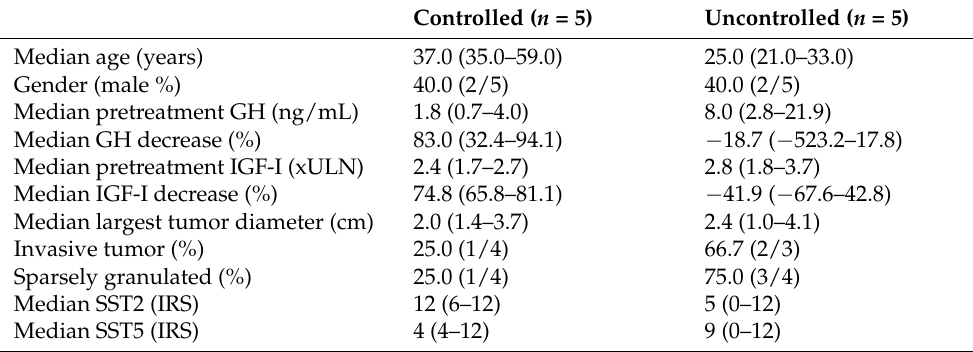
Table 2. Characterization of patients whose samples were used for miRNA